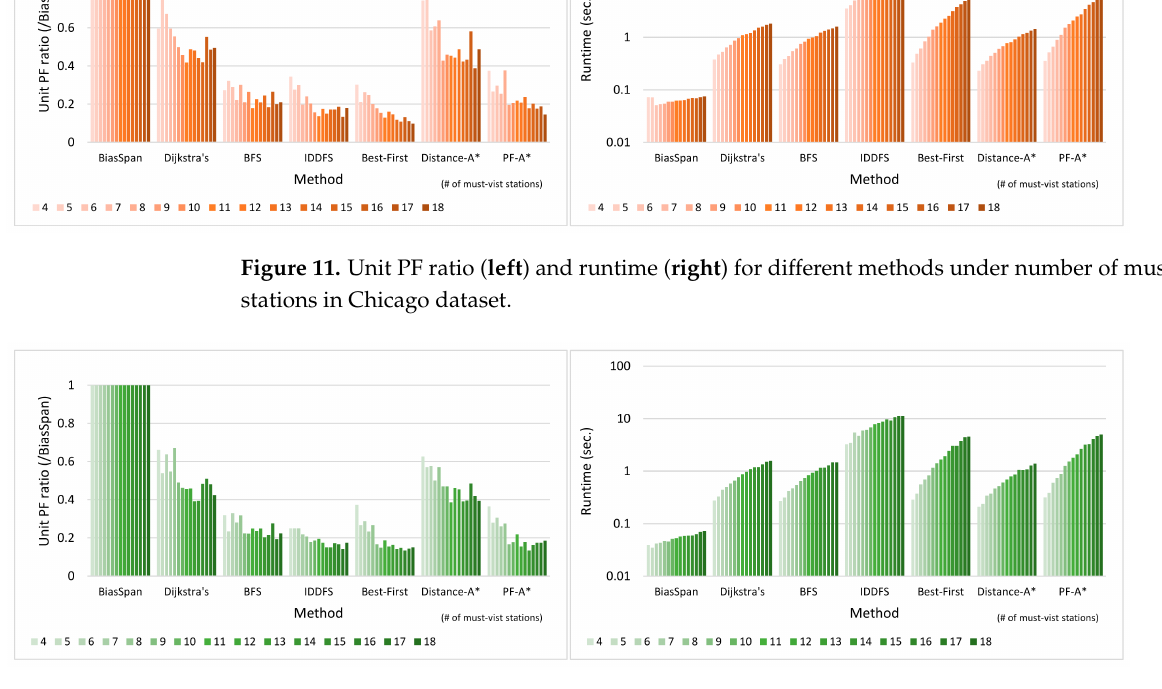
Figure 12. Unit PF ratio ( left ) and runtime ( right ) for different methods under number of must-visit stations in Tainan dataset. Table 5. Hypervolume (HV) obtained by each method under different datasets and area